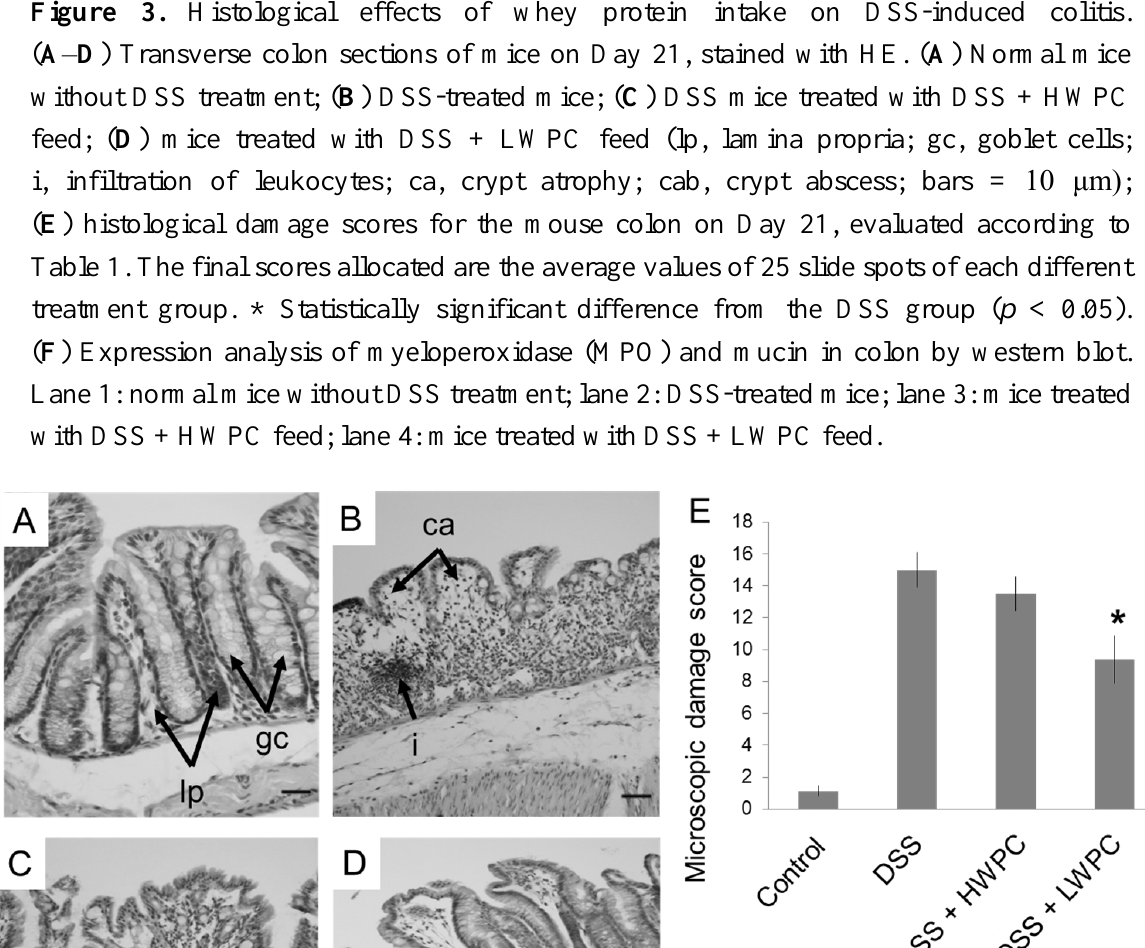
3. Histological effects of whey protein intake on DSS-induced colitis.